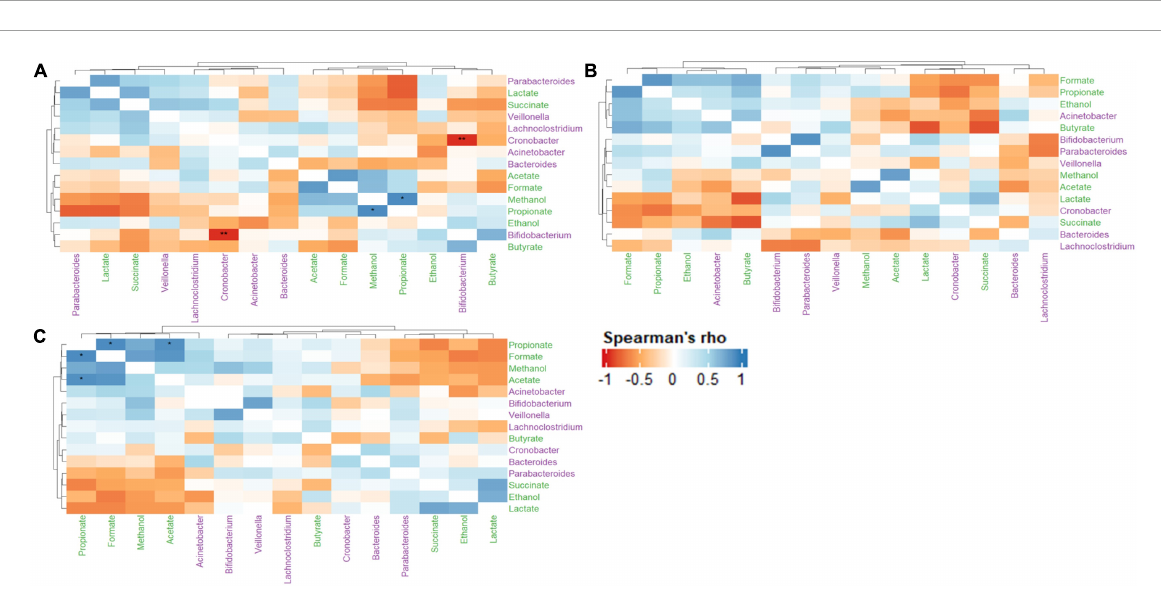
FIGURE9 Heatmap of Spearman’s rank correlation coefficients of select metabolites and microbial genera between the control (A) , LAB (B) , and LAB + VGOS (C) treatments. Microbial genera are colored in green, and metabolites are colored in purple. A positive correlation indicates that when a microbial genera or metabolite becomes more or less abundant, so does the other feature. Conversely, a negative correlation indicates that when a genera or metabolite becomes less abundant, the other feature increases in abundance. Statistical significance is indicated by the asterisks after correction with Benjamini-Hochberg false discovery rate, * P < 0.05, ** P <